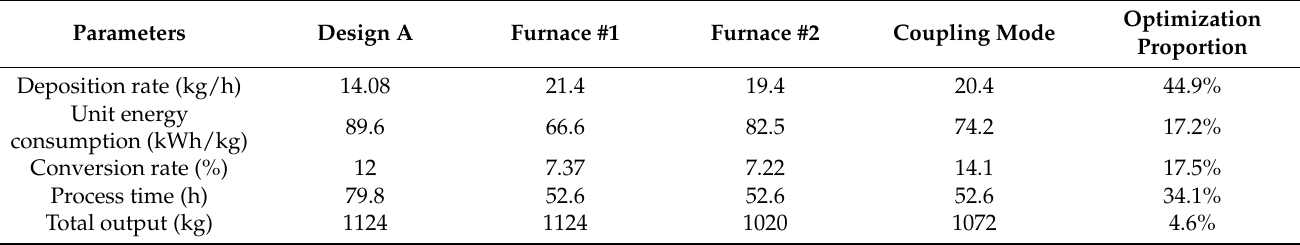
Figure 9. Temperature and velocity distributions. ( a ) Cross-sections of gas velocity; ( b ) cross-sections of temperature; ( c ) rod surface temperature (the height of cross-section is 0.5 m, 1.1 m, 1.7 m and 2.3 m, respectively). Table 7. Process